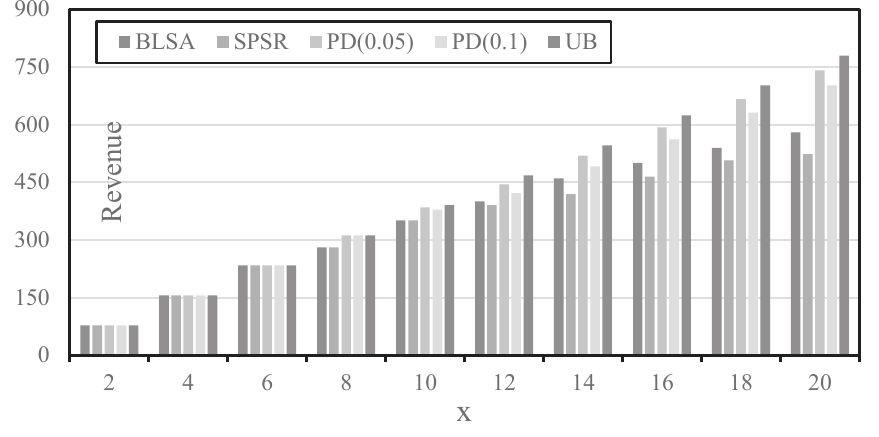
Figure 7. Revenue